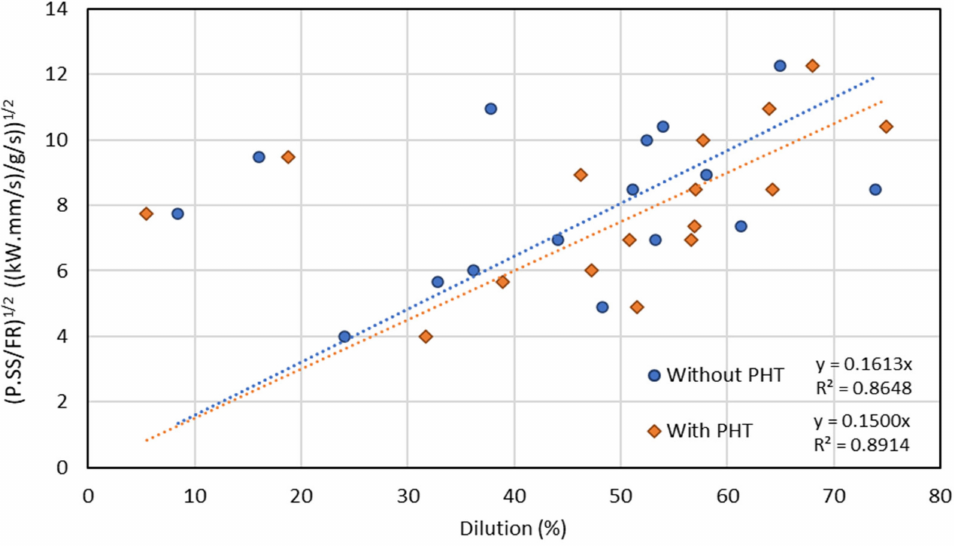
Figure 10. Dependence of dilution on the value of complex parameter